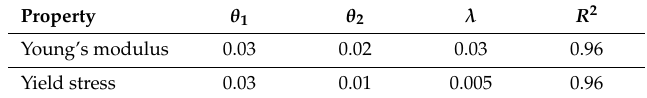
Table 2. Kriging regression.